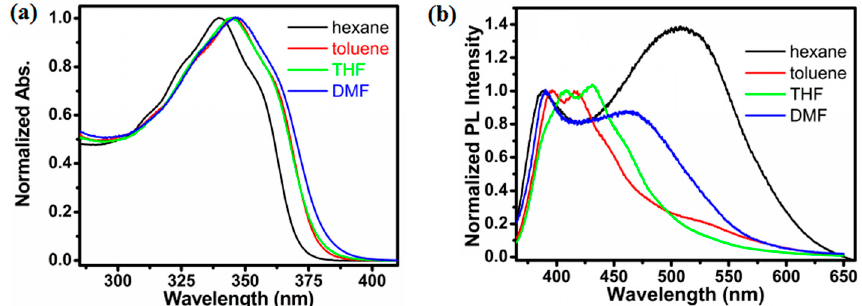
Figure 1. Normalized ( a ) absorption and ( b ) fluorescence emission spectra of compound PPDPD in different dilute solutions. DMF: dimethylformamide; THF: tetrahydrofuran.